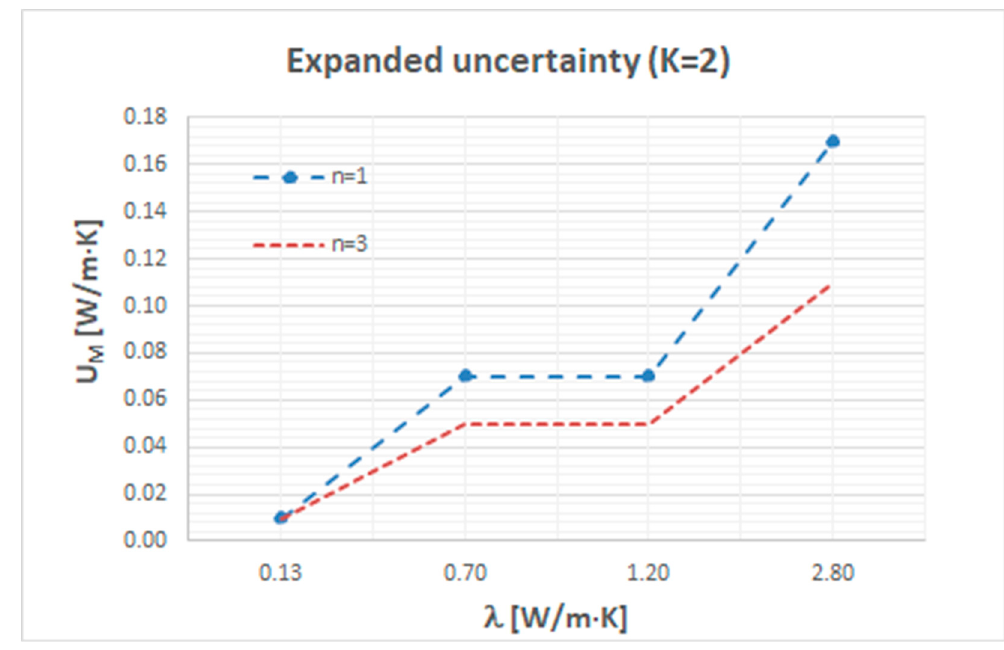
Figure 10. Graph for obtaining the expanded uncertainty with the TCMA. 𝑈 = 𝐾 ∙ 𝑢 = 2 ∙ 𝑢 (5) (cid:3014) A coverage factor 𝐾 = 2 has been used (corresponding to a level of confidence of ap-